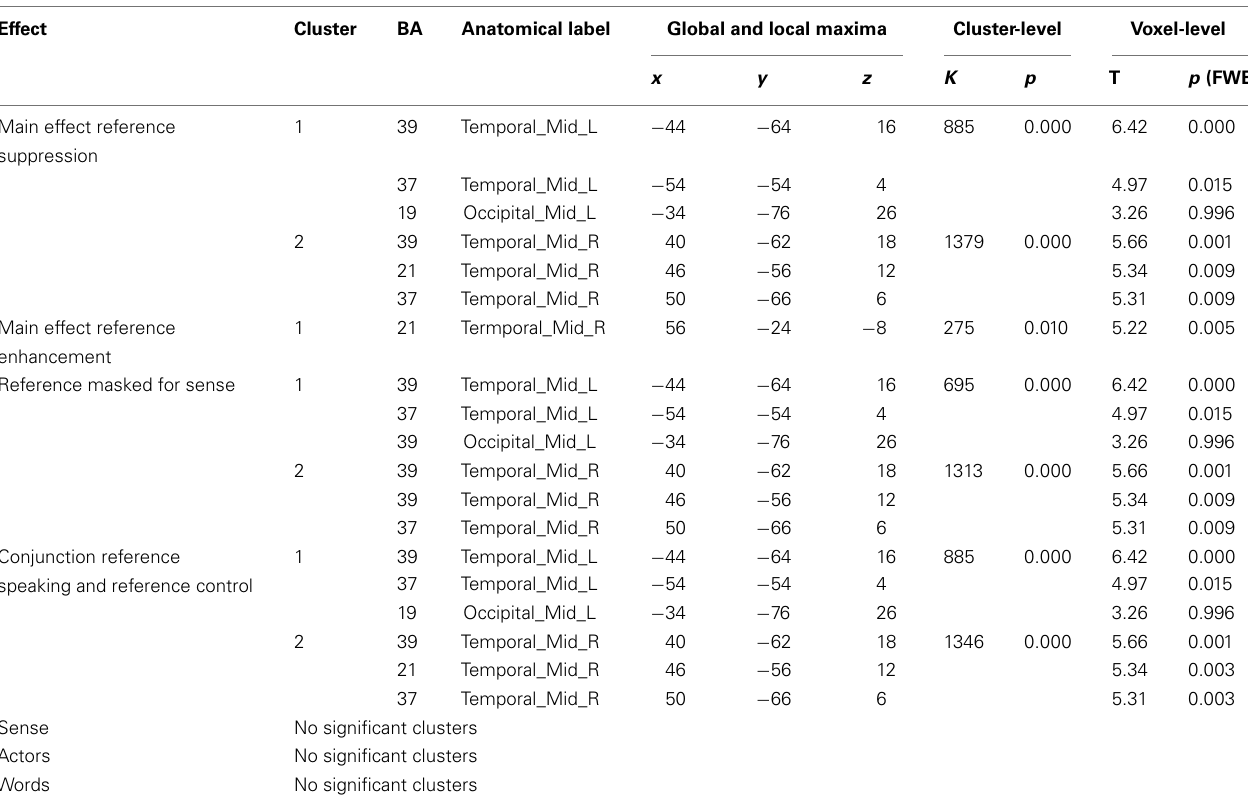
Table 3 | Results from control